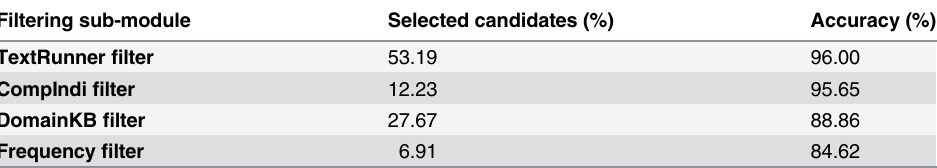
Table 5. Performance of the filtering sub-modules Filtering